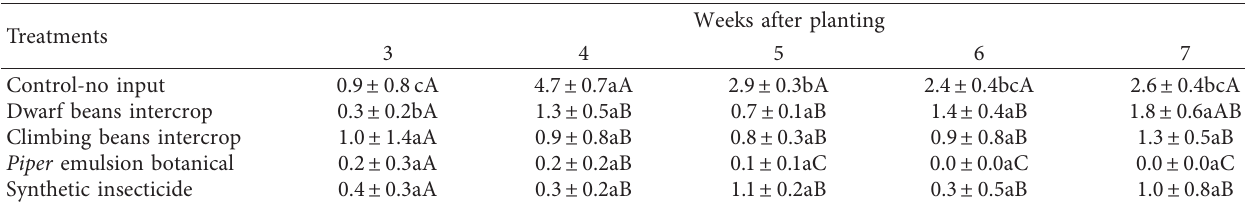
FAW larval mortality in relation to tap water as the control. Table 2: Effect of treatments on fall armyworm severity (number of larvae per plant; mean ± SD) at three to seven weeks after planting. Treatments